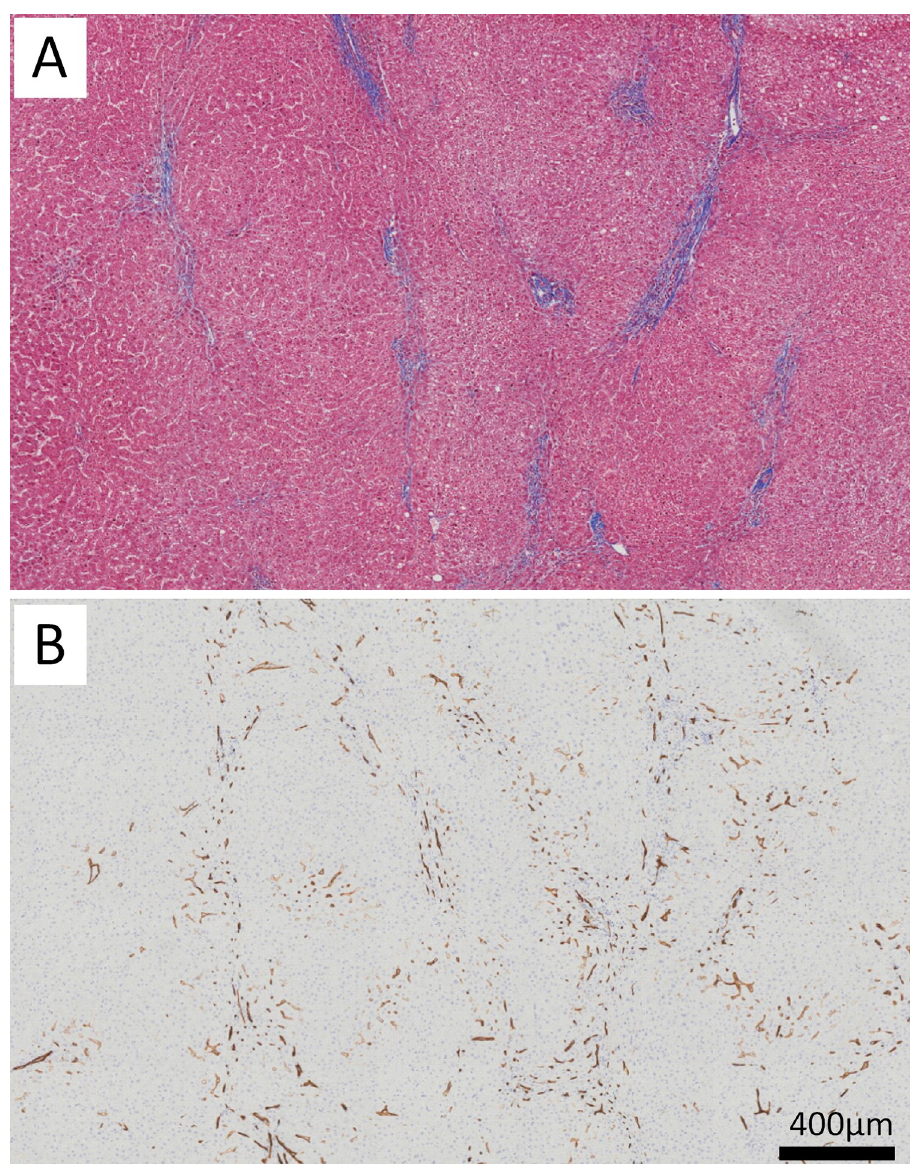
Fig 4. A patient with diabetes, mild steatosis, and overall stage 3 fibrosis. Trichrome stain showing an area with discontinuous septa but vague nodularity (A); CD34 IHC in the same region shows circumferential nodular staining (B). Scale bar is